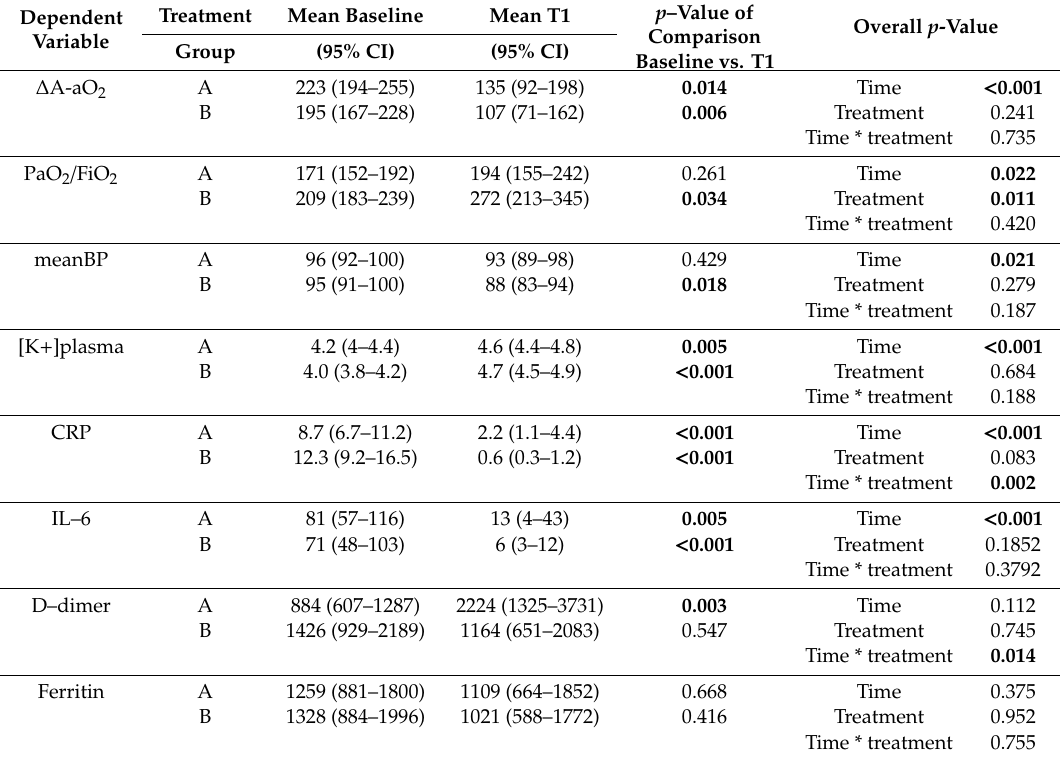
Table 2. Repeated measures analysis comparing changes in variables from baseline to follow-up (T1).